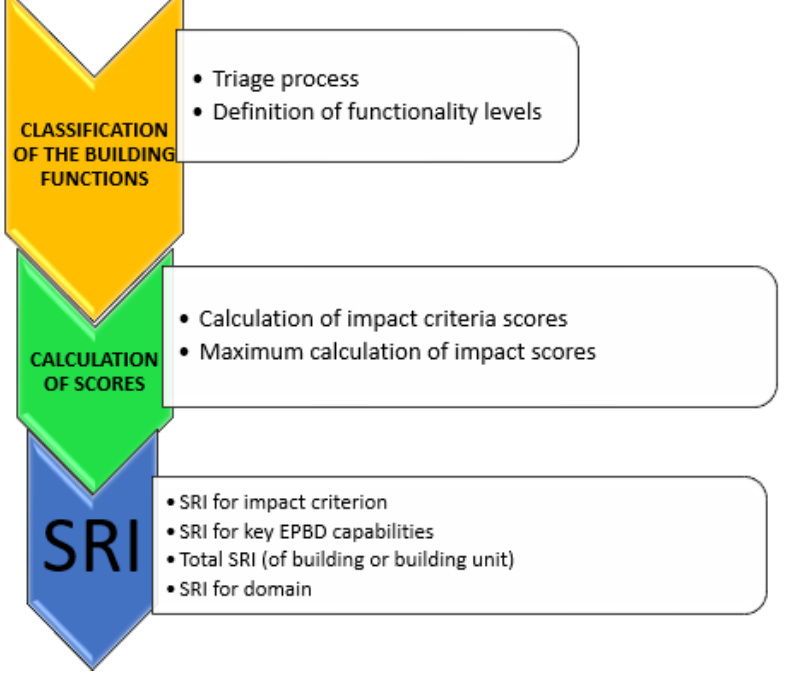
Figure 3. Flow chart of SRI calculation methodology [24].